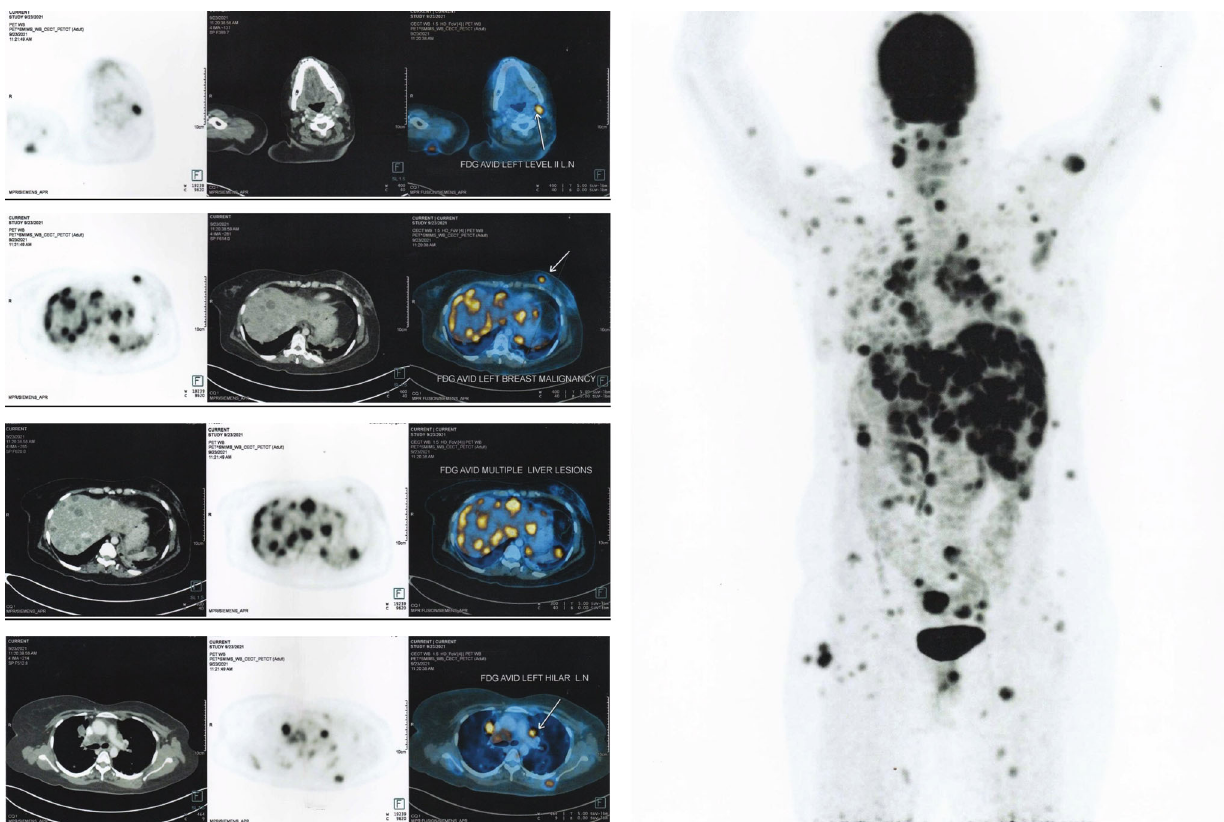
Figure 5: PET scan images showing extensive FDG avid metastases all over the